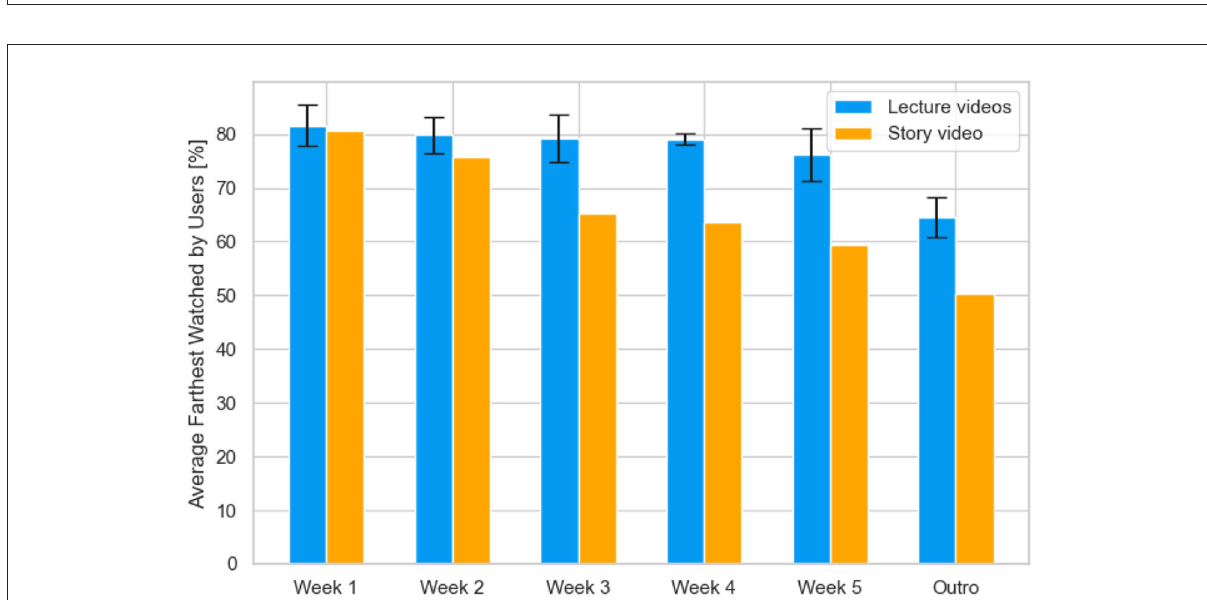
FIGURE5 Percentages of farthest watch for the lecture videos week average (including standard deviation) compared to the weekly story video. On course average, story videos were watched 67.9% (SD 11.42%) of their total length, and lecture videos 77.25% (SD 6.3%) (Hagedorn et al.,